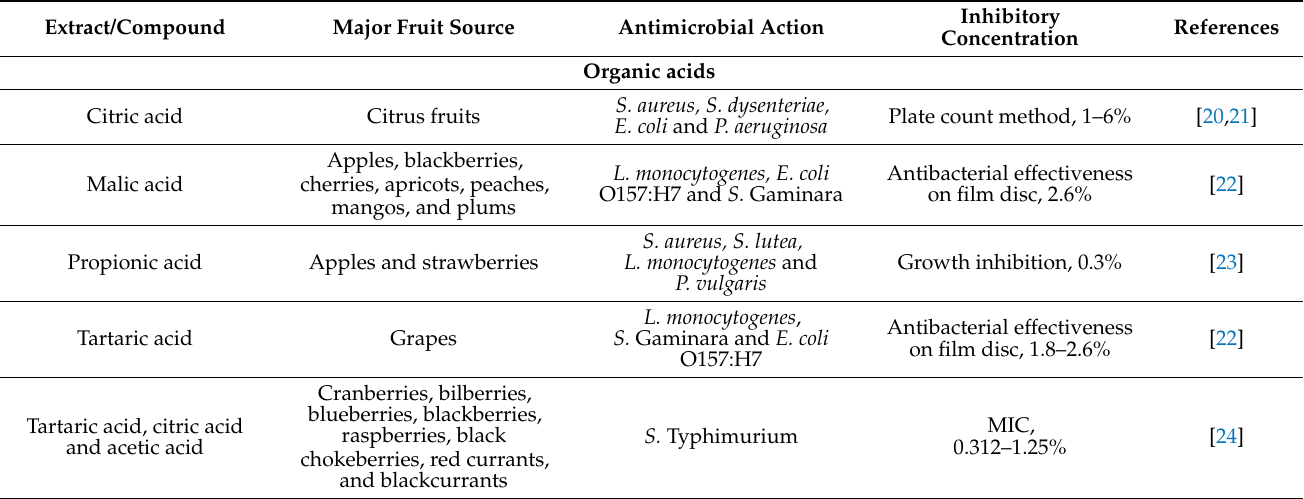
Table 1. Components of fruit extracts as antimicrobial